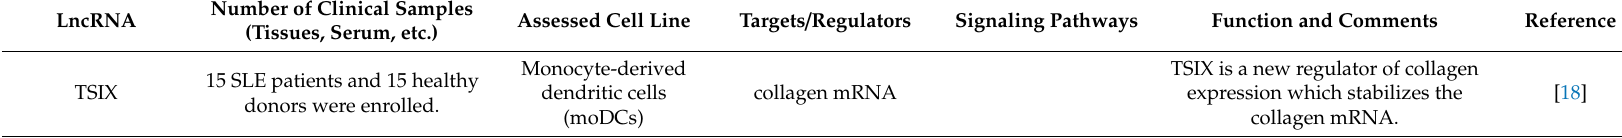
Table 2. List of lncRNAs whose expression has been upregulated in SLE